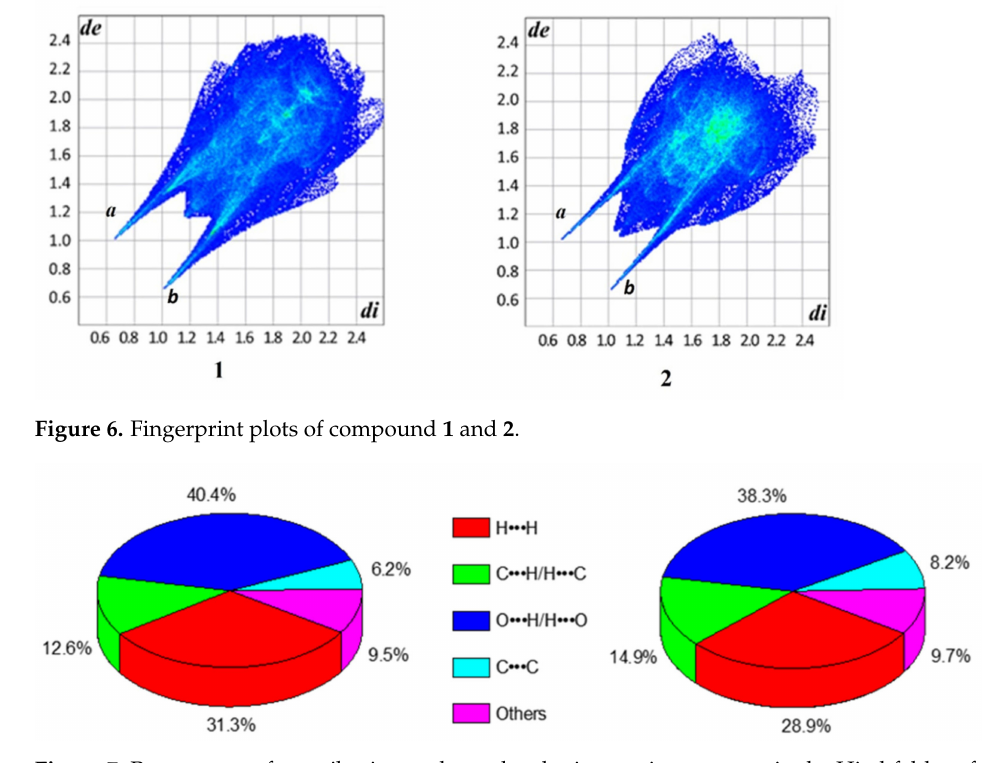
Figure 7. Percentages of contribution to the molecular interactions present in the Hirshfeld surfaces of complexes 1 ( left ) and 2 ( right